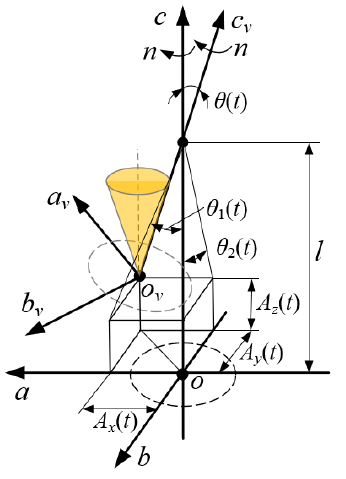
Figure 2. Offset model of cutter tooth position under vibration.